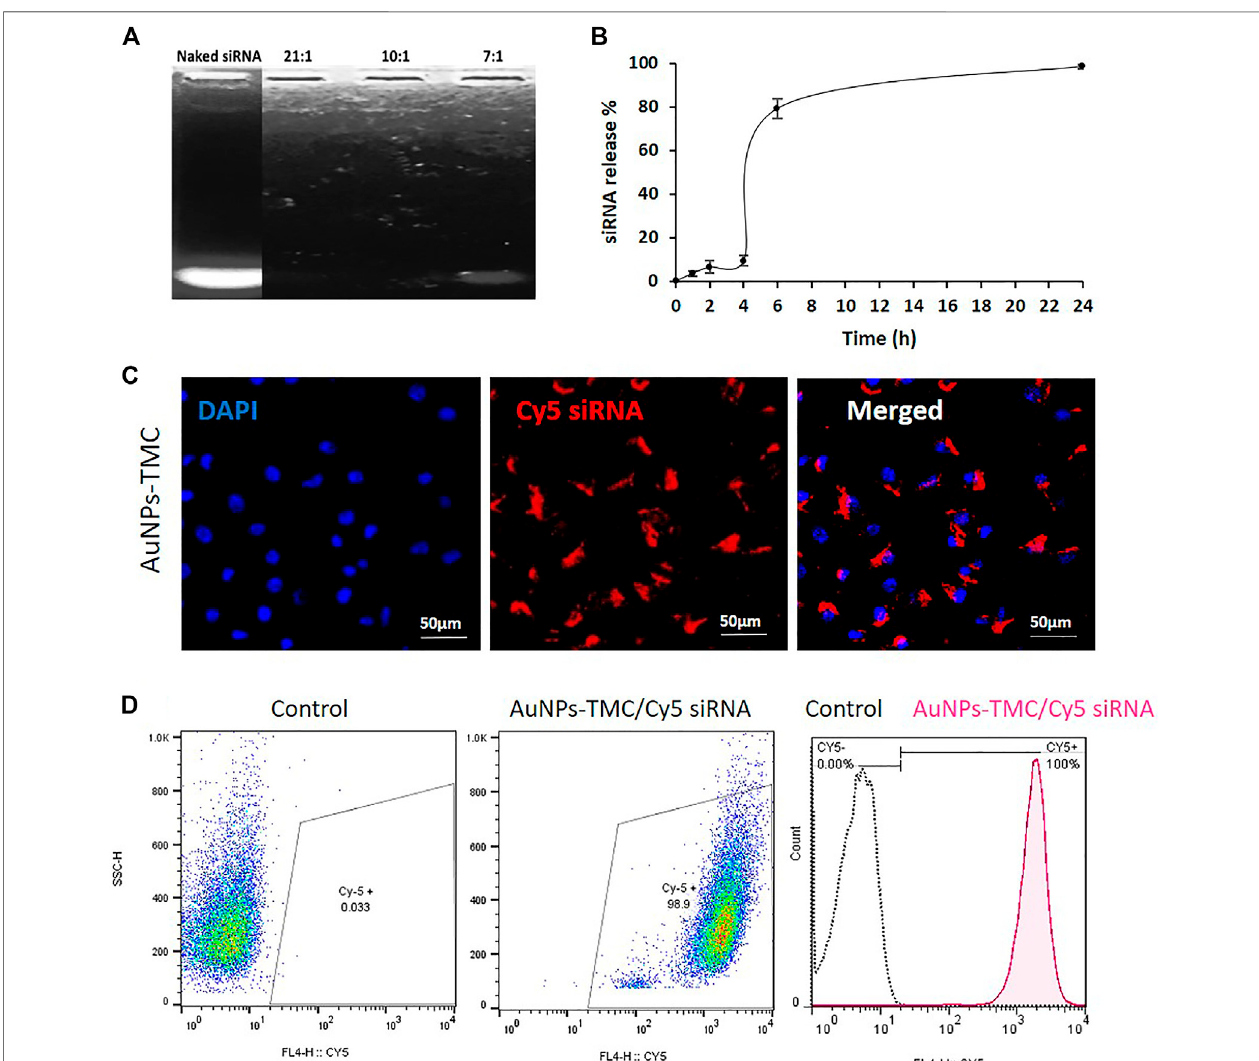
FIGURE2| Stability,releasepro fi leandcellularuptake ofAuNPs-TMC/siRNA. (A) Agarosegelelectrophoresis fornakedsiRNAanddifferentw/wratios ofAuNPs- TMC/siRNA. (B) ReleasePro fi leofsiRNAfromAuNPs-TMC/siRNAin10:1w/wratioin10%FBSaqueousmediaat37 ° C.ThepercentageoffreesiRNAwasmeasuredat 0,1,2,4,6,and24 htimepoints,dataarepresentedasmean±SDoftriplicates.CellularuptakeofAuNPs-TMC/Cy5-labeledsiRNA(w/wratio10:1)inMCF-7cellsafter 4 h incubation. (C) Confocal microscopy images (The cell nuclei were stained by DAPI). (D) Flow cytometry analysis; which is shown in histogram with the X-axis indicating the mean fl uorescence intensity and the Y-axis indicating the cell